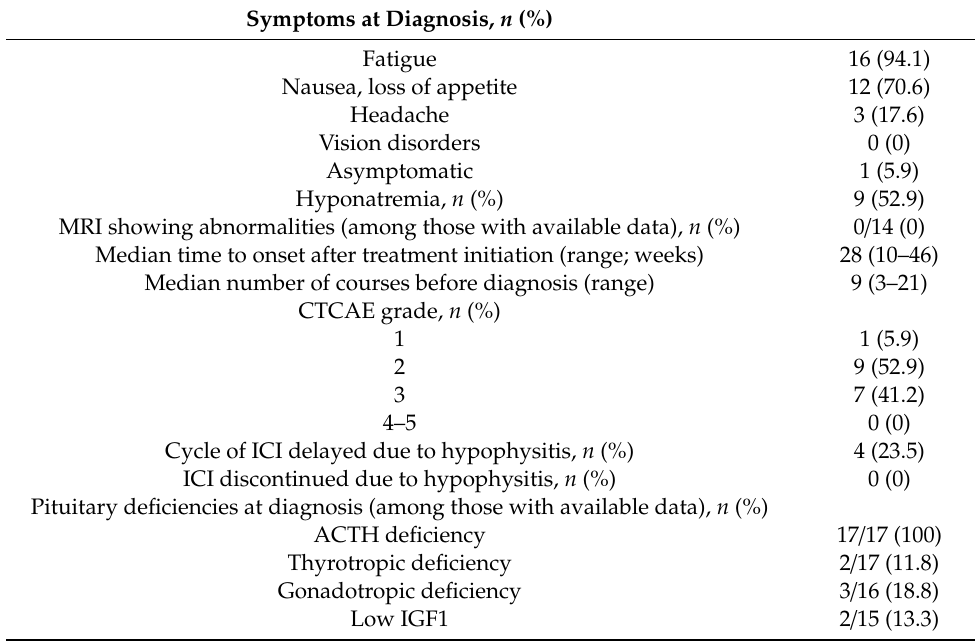
Table 2. Description of hypophysitis at diagnosis ( n =